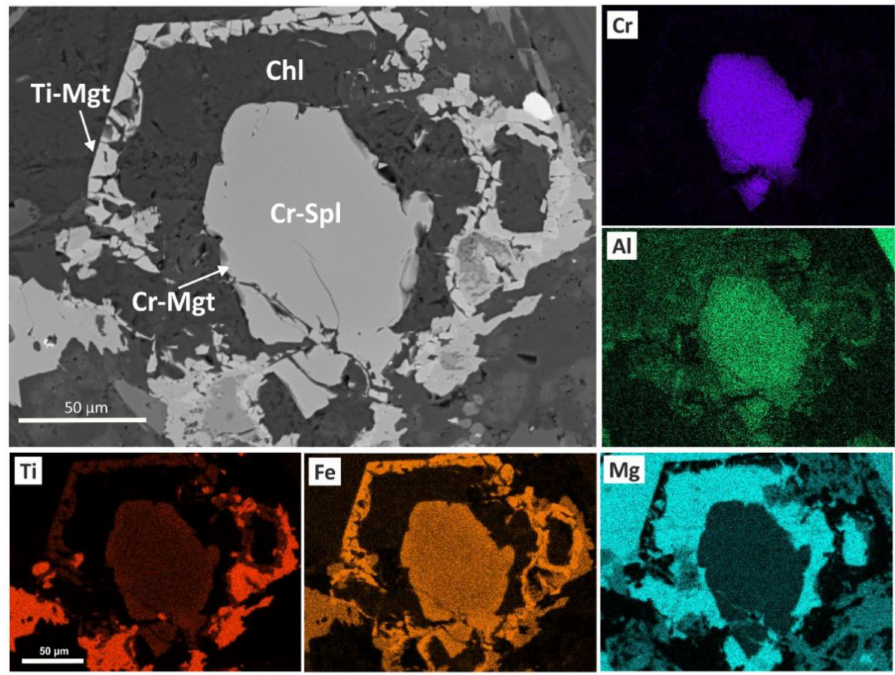
Figure 3. Atoll spinel from the aillikites of Terina, BSE images and electron microprobe (EMP) X-ray element